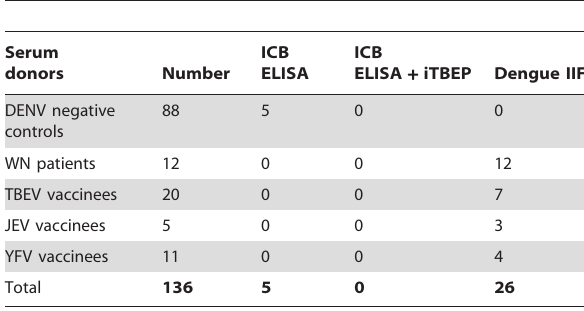
Table 1. False positive reactions obtained with any of the four DENV ICB ELISAs and with